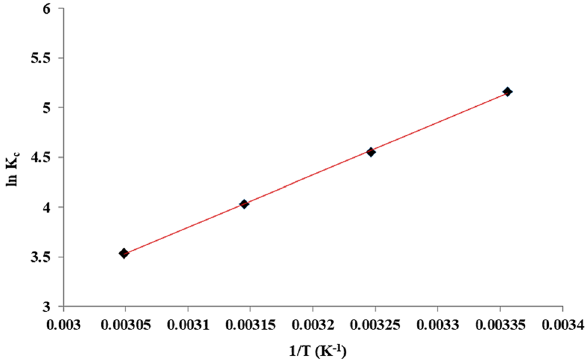
Figure 19. The plot of ln K c versus 1/T.